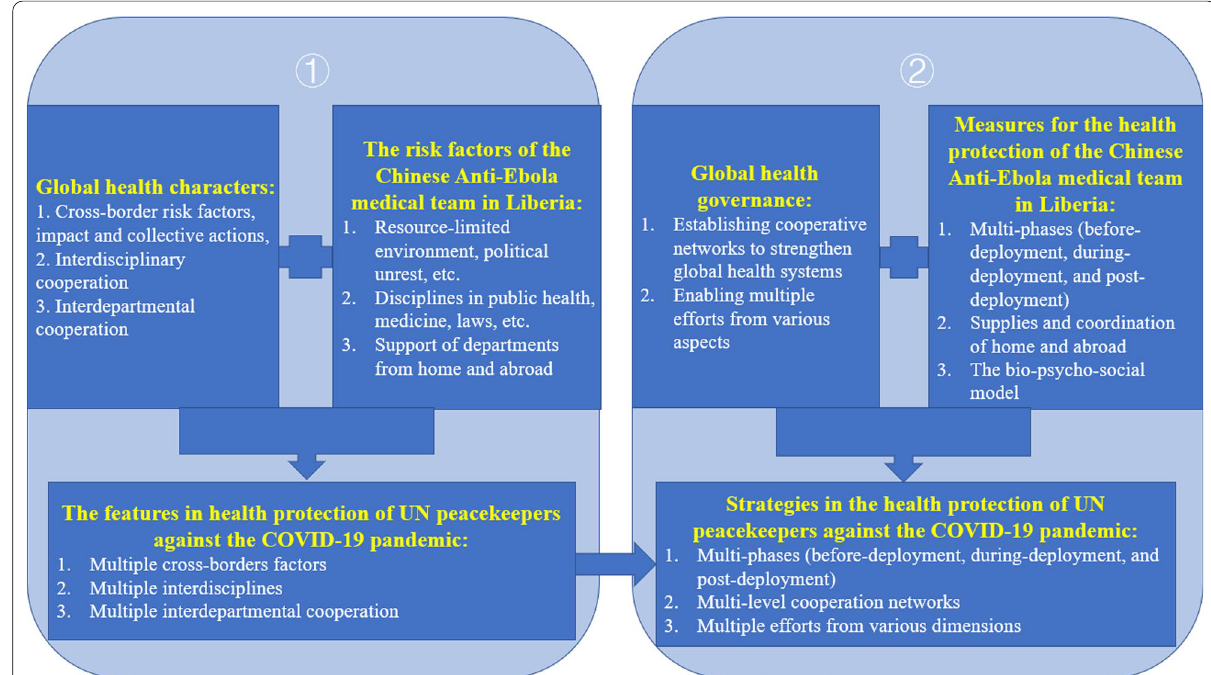
Fig. 1 A conceptual framework of the health protection among UN peacekeepers against the COVID-19 pandemic from global health perspectives. This figure illustrates the development of a conceptual framework of health protection among UN peacekeepers against the COVID-19 pandemic from global health perspectives, and refers to the successful experience of the health protection of the Chinese Anti-Ebola medical team in Liberia. These features include multiple cross-borders, multiple interdisciplines, and multiple interdepartmental cooperation. These strategies include multi-phases, multilevel cooperation networks, and multiple efforts from various